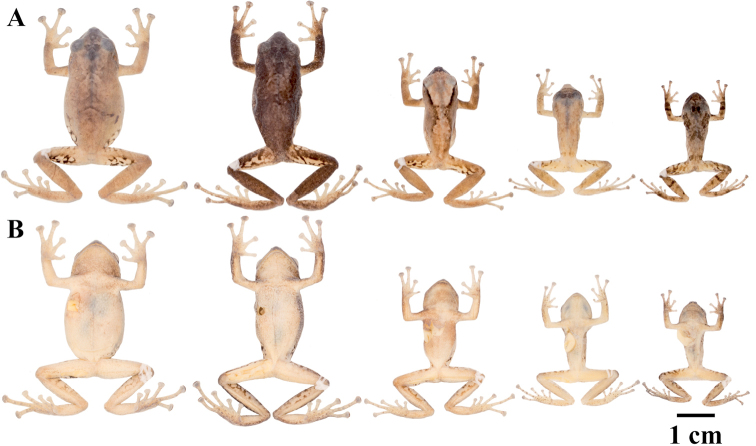
Color variation in preserved individuals of Pristimantis
phoxocephalus. A Dorsal view of (from left to right): QCAZ 58463 (female), QCAZ 58472 (female), QCAZ 58470 (male), QCAZ 58468 (male), QCAZ 58461 (male). B Ventral view of the same specimens. See Suppl. material 2 for locality data. All specimens are shown at the same scale.